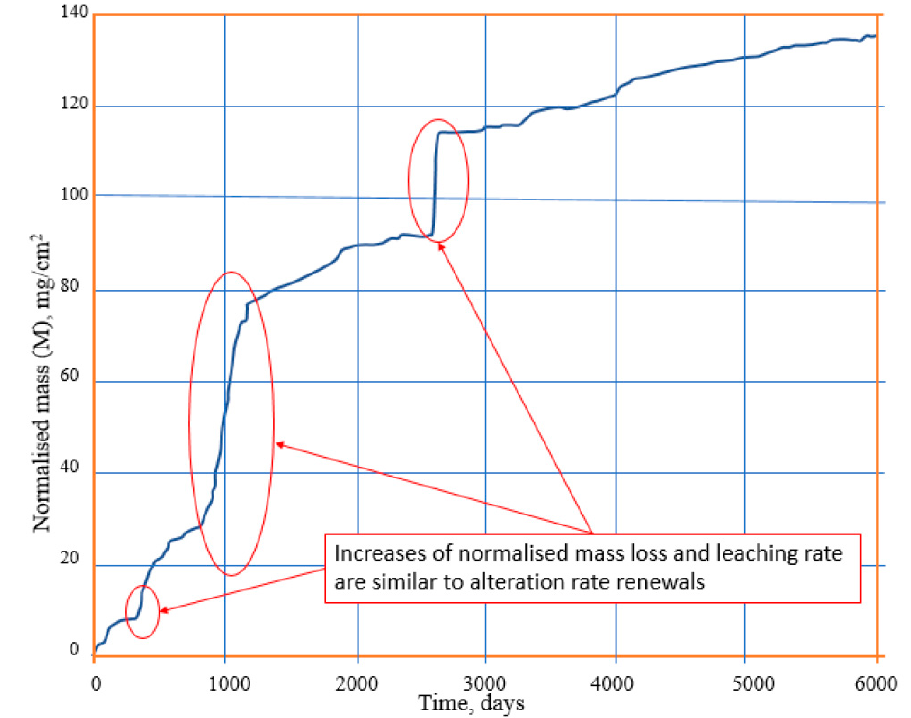
Figure A2. The normalized mass losses of 137 Cs from glass.